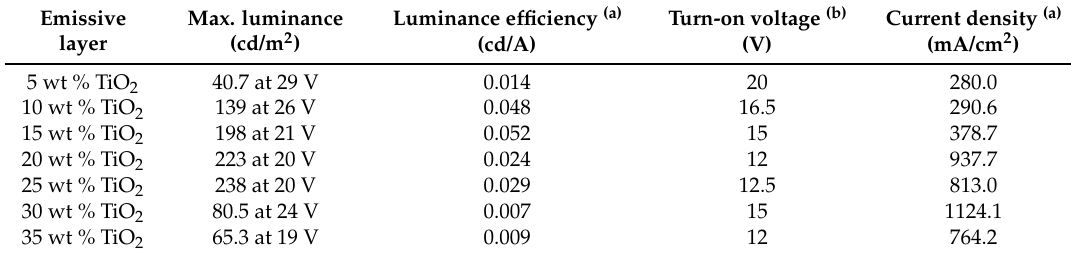
Figure 2. Current density–voltage (J–V) characteristics of the PFO/Fluorol 7GA/TiO 2 organic light emitting diode (OLED) devices. Table 1. Optoelectronic characteristics of PFO/0.5 wt % Fluorol 7GA/TiO 2 light emitting diodes at various contents of TiO 2 NPs.